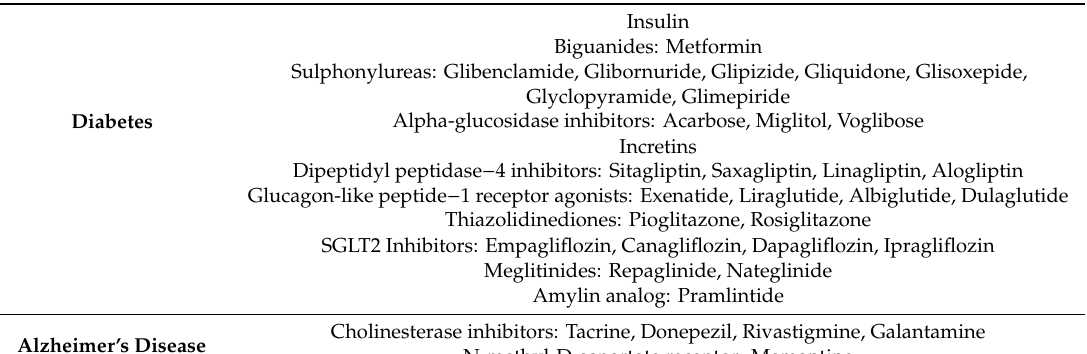
Table 1. Current therapies in diabetes and Alzheimer’s